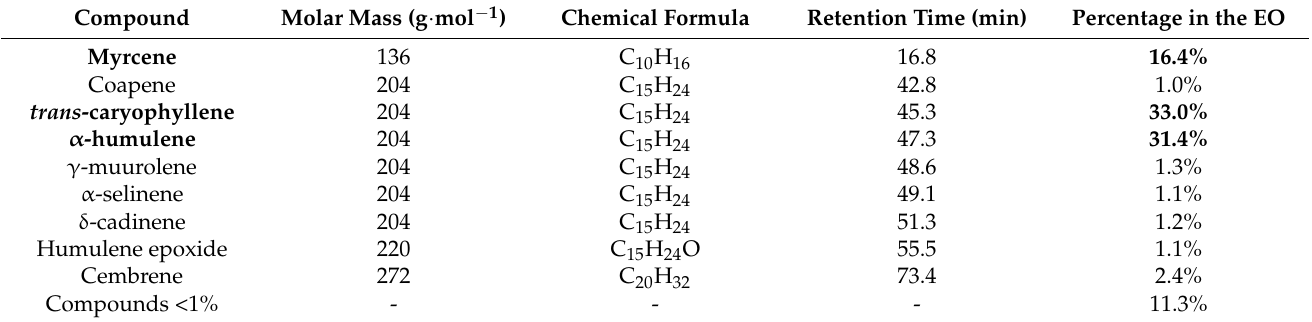
Table 2. Compounds with levels greater than 1% in the commercial essential oil from hop cones.